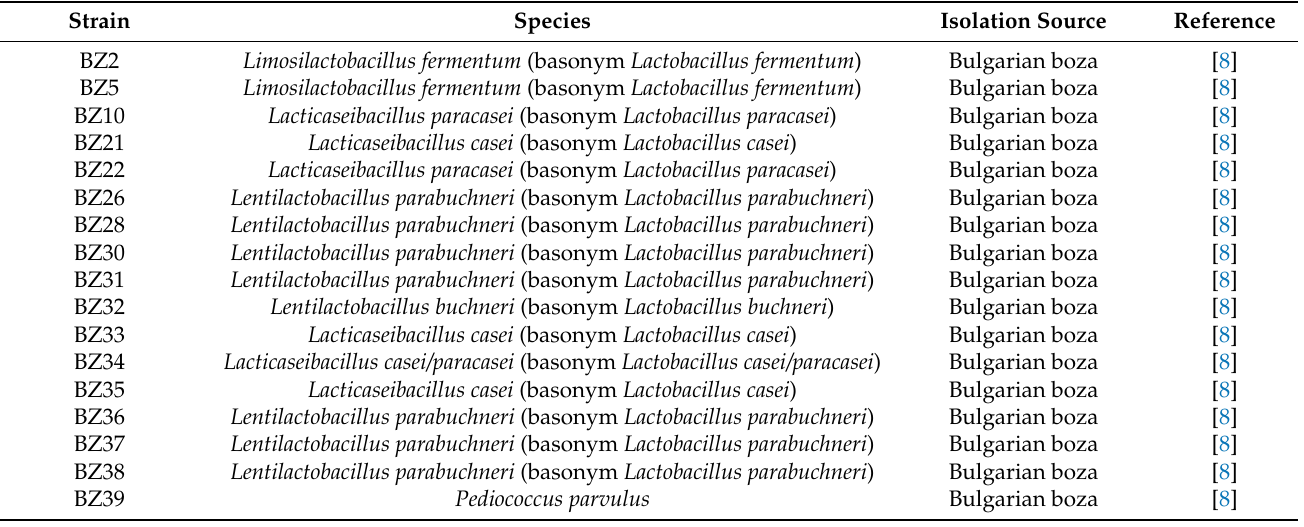
Table 1. The twenty-three lactic acid bacteria strains assayed in the present study for the fermentation of three cereal- and pseudocereal-based